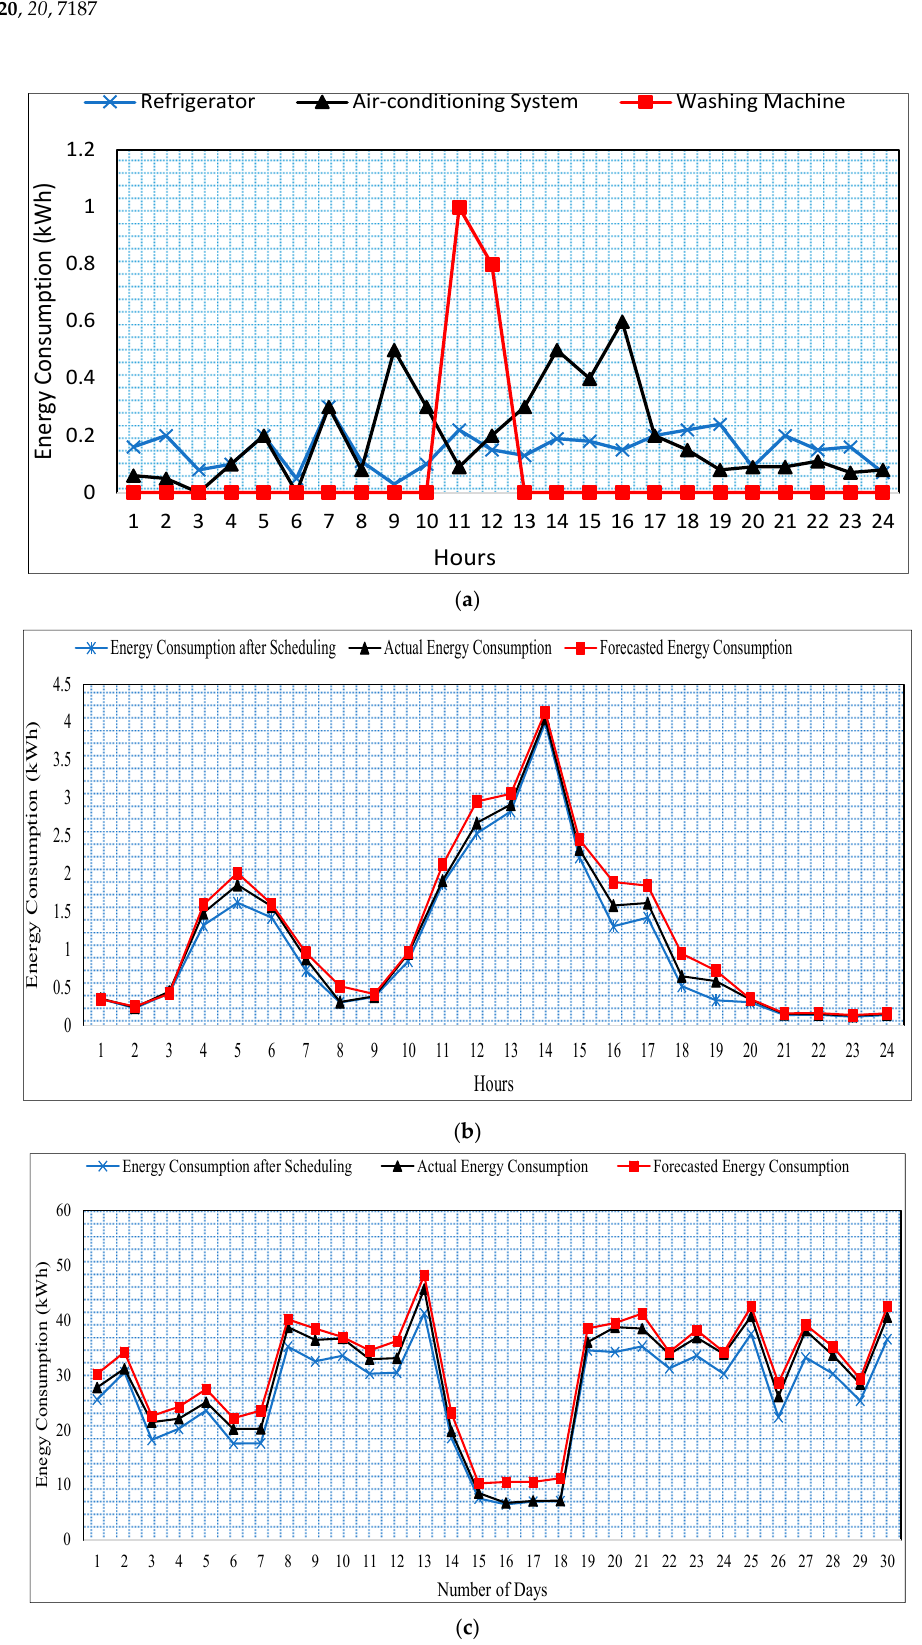
Figure 8. ( a ) Energy consumption of refrigerator, air-conditioning system, and washing machine, ( b ) Energy Consumption comparison of actual, forecasted, and after scheduling for one day ( c ) Energy Consumption comparison of actual, forecasted, and after scheduling for a period one